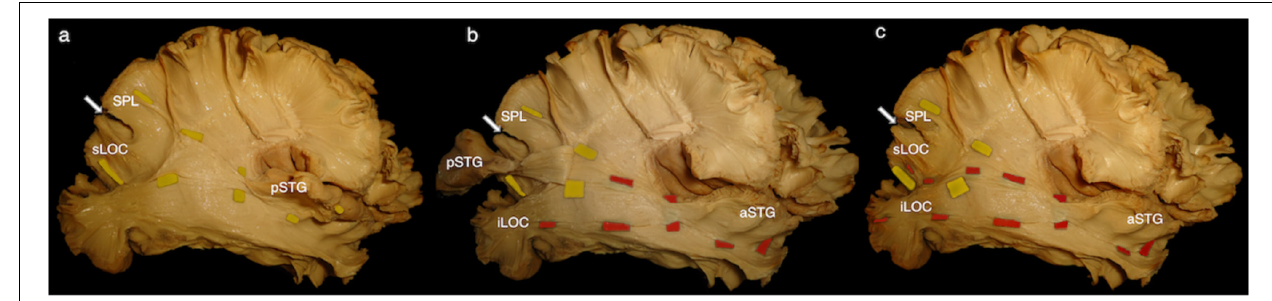
FIGURE 3 | Right hemisphere, infero-lateral view. (a) Posterior middle longitudinal fascicle (pMdLF). Yellow tags underline the path of the pMdLF, which is the posterior, superficial branch of the MdLF: anterior terminations are in the posterior superior temporal gyrus (pSTG), namely anterior temporal transverse gyrus and the planum temporale; posterior terminations go across the parieto-occipital sulcus (POS; white arrow) at the superior parietal lobule (SPL) and at the superior lateral occipital cortex (sLOC). (b) Anterior middle longitudinal fascicle (aMdLF). pSTG has been disconnected and the stripped posteriorly along with pMdLF fibers, showing the deeper, anterior segment of the MdLF (aMdLF). Red tags show the path of the aMdLF from the anterior superior temporal gyrus (aSTG), including planum polare and temporal pole, to the LOC. (c) After completely removing pSTG and main fibers of the pMdLF, the entire aMdLF is uncovered. While no fibers of the aMdLF were detected above the POS, we found that both the aMdLF and pMdLF had terminations at the level of the sLOC. Only the aMdLF showed cortical terminations at